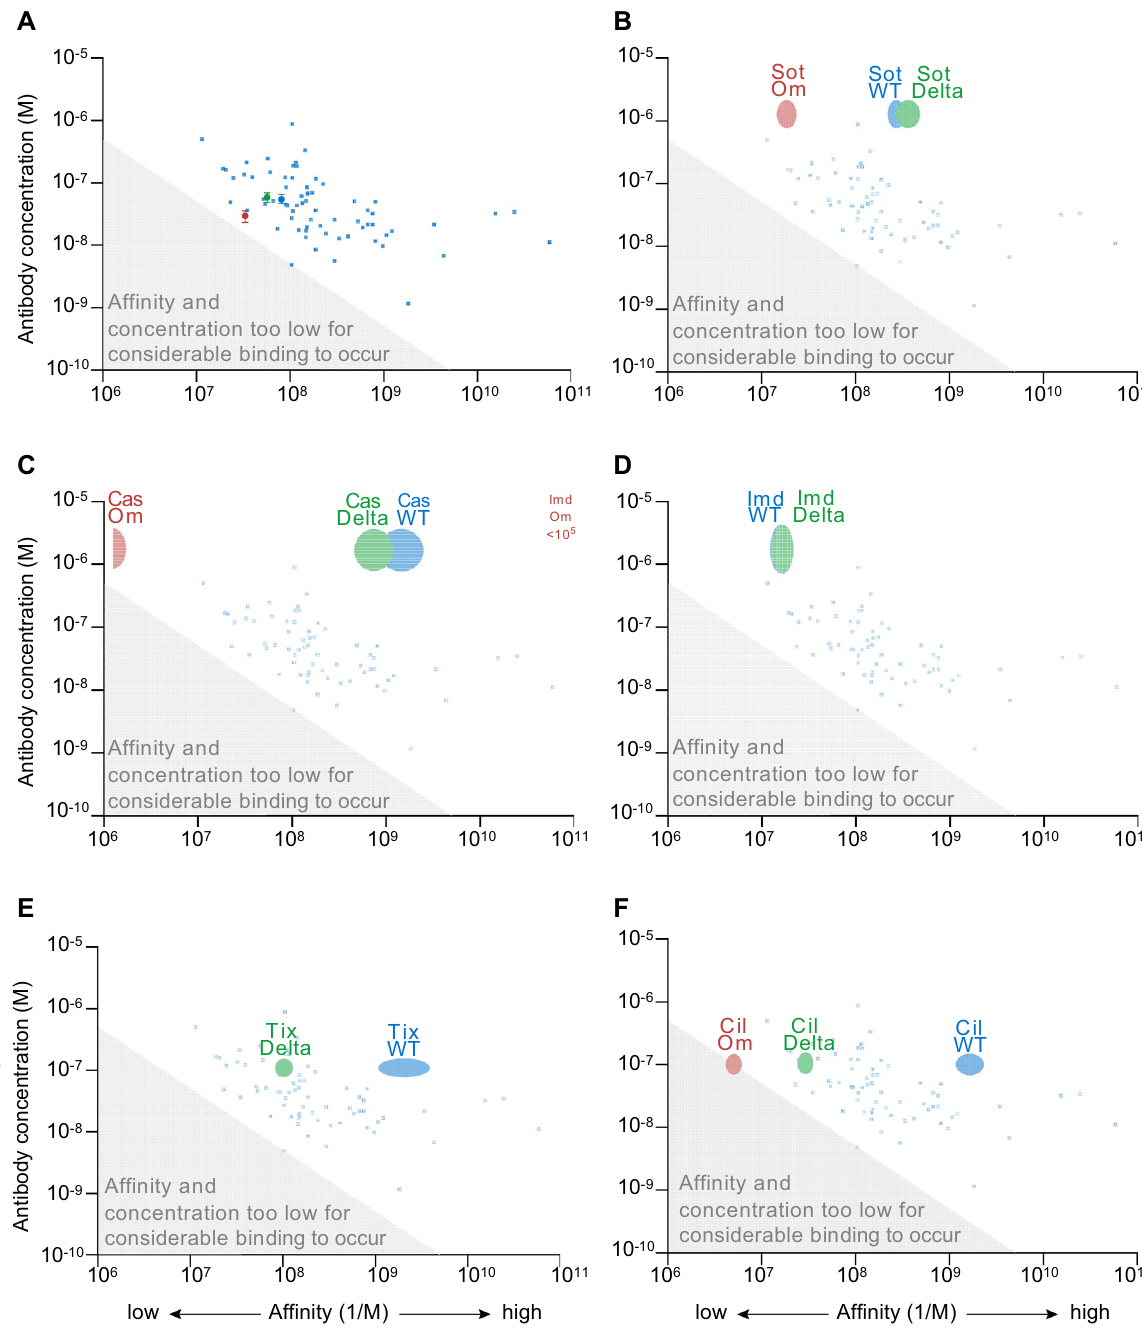
Figure 4. Affinities and average maximum post-dosage concentrations of therapeutic antibodies in comparison with affinities and concentrations of serum or plasma of COVID-19 convalescent individuals. ( A ) serological fingerprints of COVID-19 unvaccinated, convalescent individuals (see Table S3 for details) using wild type RBD as an antigen in context with fingerprints of the working reagent for anti-SARS-CoV-2 immunoglobulin 24 (pooled plasma of COVID-19 convalescents) using wild type spike RBD (blue), Delta spike RBD (green), or Omicron BA.1 spike RBD (red) as antigens. The shaded gray region of the plot indicates the area where antibody concentration is less than K D /2 such that binding site concentration is less than K D and so binding is not able to exceed 50%. ( B – F ) Affinities of ( B ) sotrovimab, ( C ) casirivimab, ( D ) imdevimab, ( E ) tixagevimab, and ( F ) cilgavimab in comparison with the serological fingerprints of convalescent donors shown in ( A ). The width and height of the monoclonal antibody ovals are the standard error affinities ( K A determined by MDS) against wild type spike RBD (blue), Delta spike RBD (green), or Omicron BA.1 spike RBD (red) and maximum serum concentrations obtained after dosage 32–34 (average ± 1 SD),